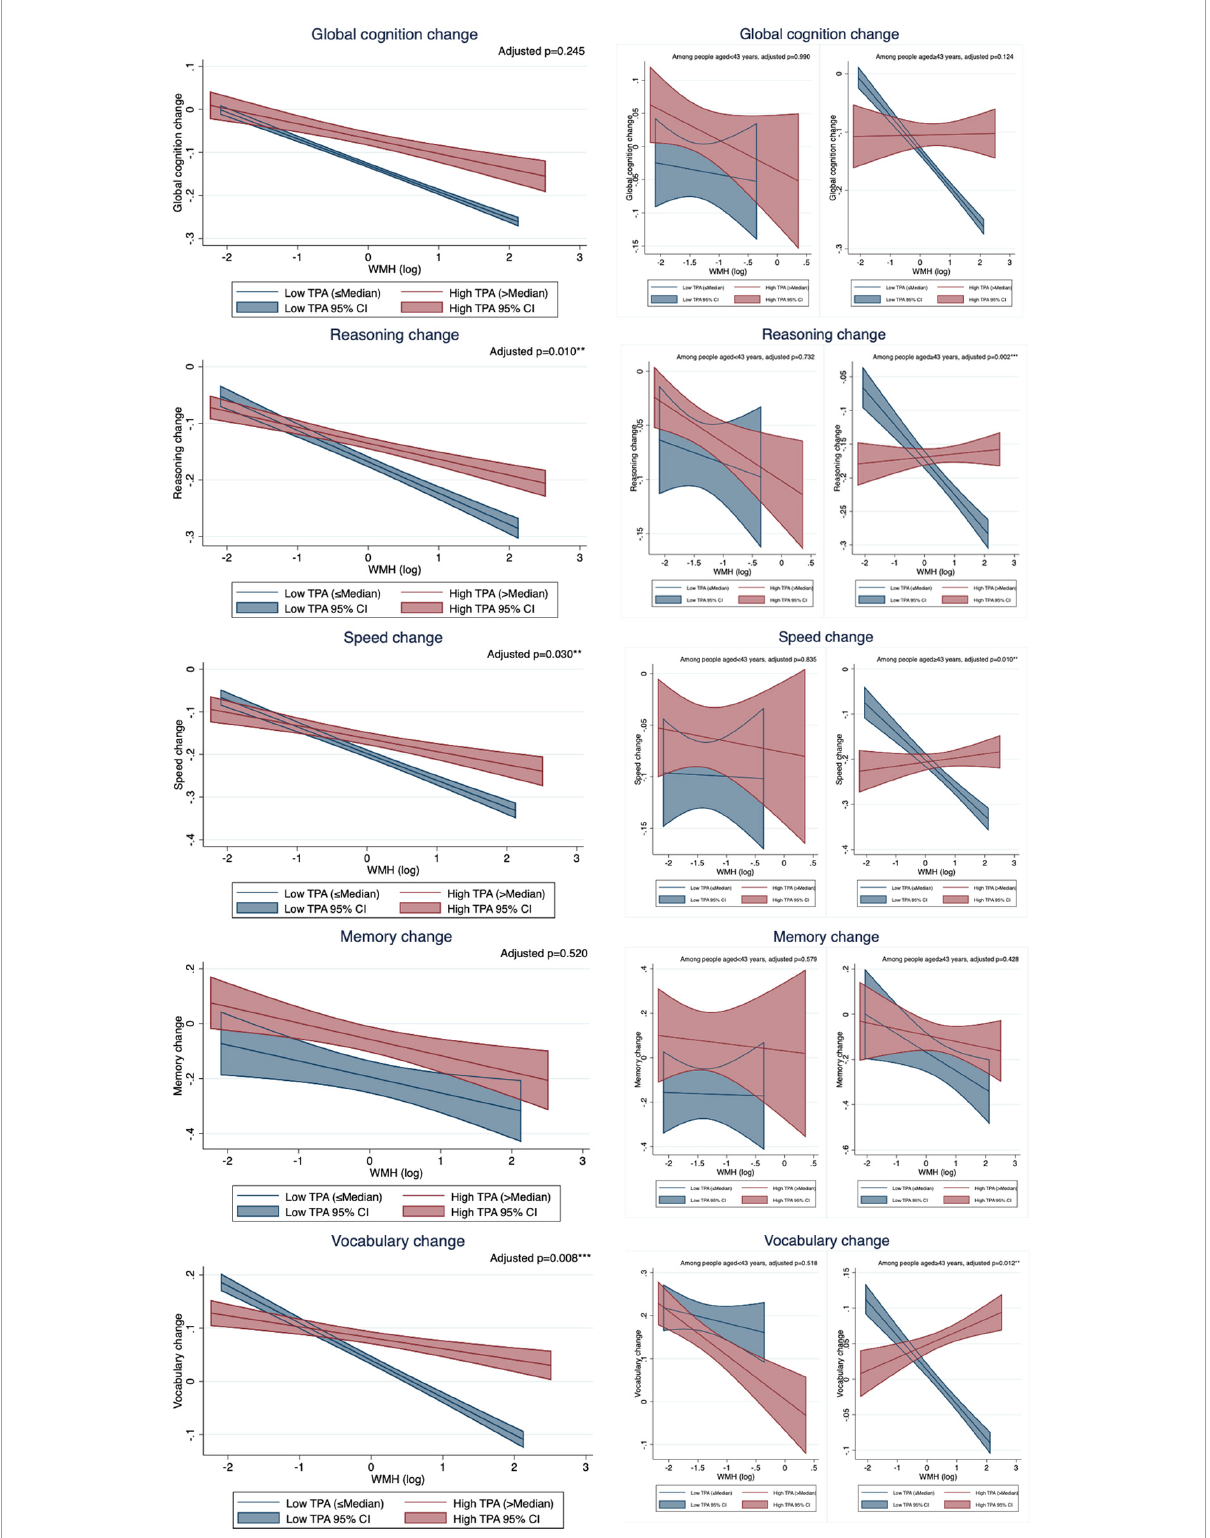
FIGURE1 The relationship between white matter hyperintensity (WMH) and cognitive change by total physical activity (TPA) group. TPA, total physical activity; WMH, white matter hyperintensity. All models controlled for age, sex, education, and baseline cognition. Adjusted p -values were the p -values of the interaction term between WMH and binary TPA